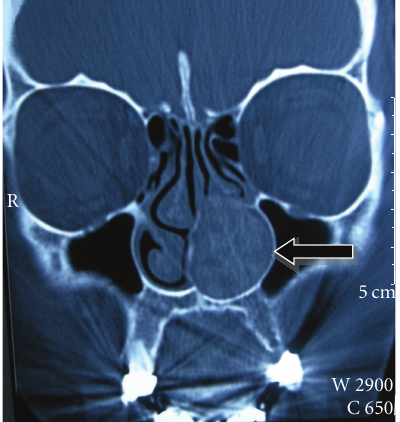
Figure 2: Paranasal sinus computed tomography coronal section showing the bonny mass originated from the inferior turbinate that filled the left nasal cavity.